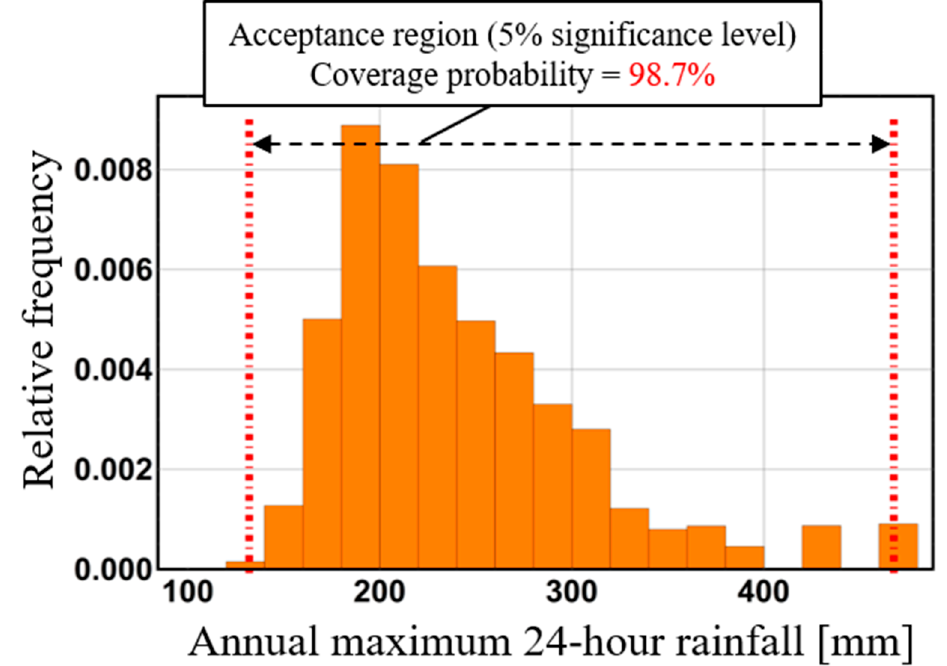
Figure 20. Acceptance region based on probability limit method test with 5% two-sided probability for Bayesian updated Gumbel distribution fitted to analytical data vs. a histogram of 49th-order statistics constructed from 5000 resampled samples from future experiment data.